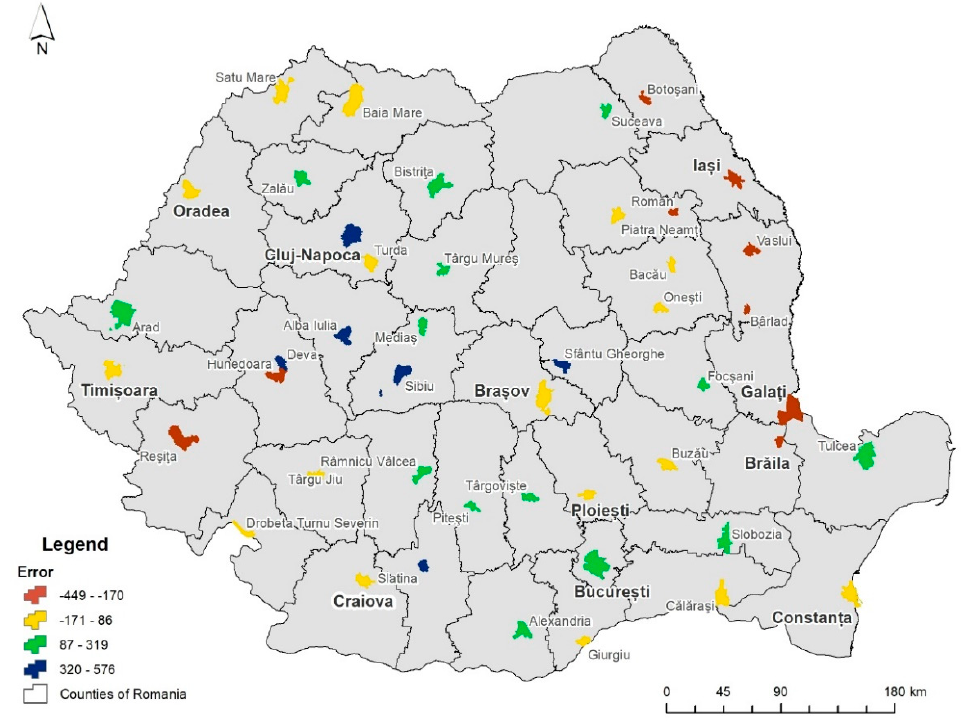
Figure 3. The regression error values for the year 2018.